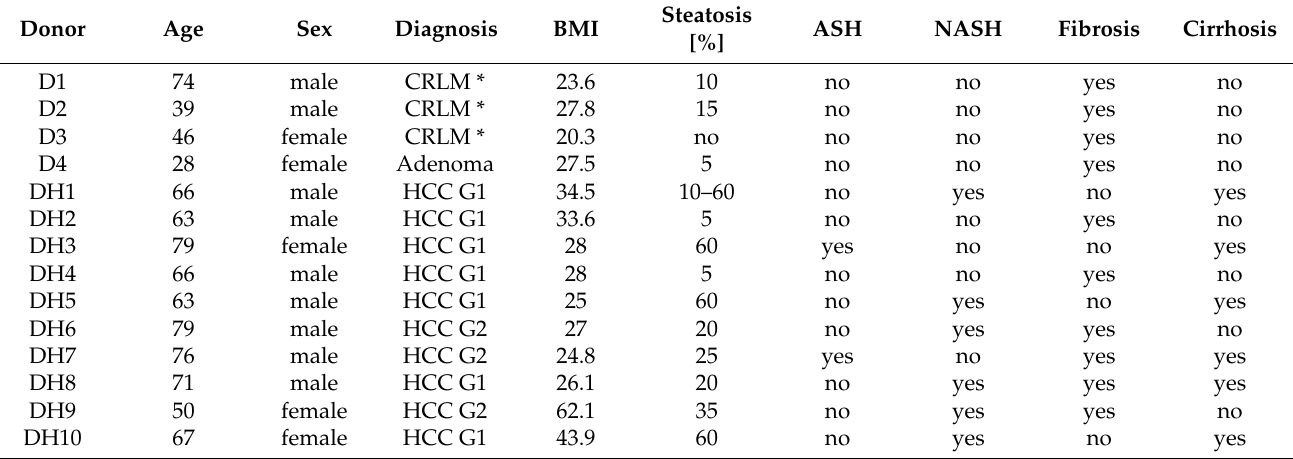
Table 1. Donor specifications for tissue samples used for primary cell isolation. List of donor number, age, sex, diagnosis and characteristics. Patients are grouped according to diagnosis (non-HCC (D1–4) and HCC